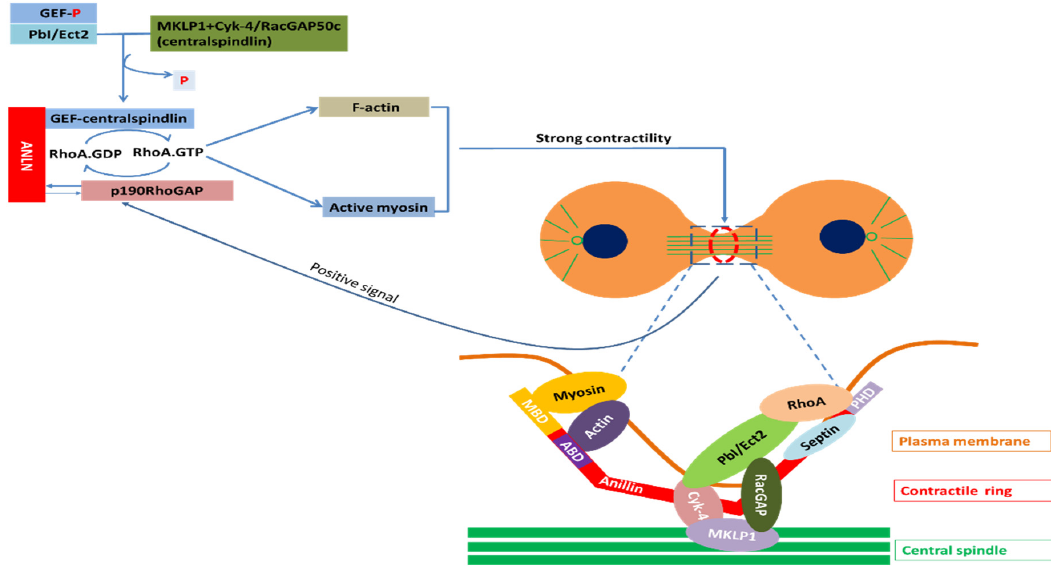
Figure 3. Partners of ANLN in cytokinesis; Myosin, a superfamily of motor proteins; Actin, a family of globular multi-functional proteins that form microfilaments; RhoA, a small GTPase protein in the Rho family of GTPases; Septin, a group of GTP-binding proteins; Cyk-4, a Rho family GTPase-activating protein (Gap) required for central spindle formation and cytokinesis; MKLP1, a member of the kinesin-like protein family; RhoA activation: Ect2, epithelial cell transforming 2 in mammalian cells or PbI in Drosophila ; ANLN, anillin actin-binding protein; MBD, myosin-binding domain; ABD, actin-binding domain; PHD, pleckstrin homology domain; GEF, guanine nucleotide exchange factors; p190RhoGAP, Rho GTPase-activating proteins; RacGAP, Rac GTPase-activating protein [96,99].